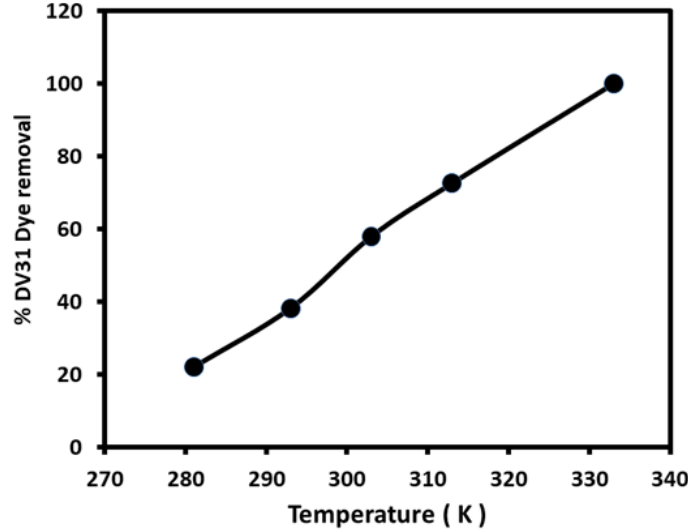
Figure 10. Effect of solution temperature on the removal of DV31 dye from aqueous solution using G CuO NPs. (Experimental conditions: DV31 dye concentration 25 mg/L; sample volume 100 mL; 10.0 mg CuO NPs;0.5 mL H 2 O 2 ; 10 min contact time and pH 8.6).